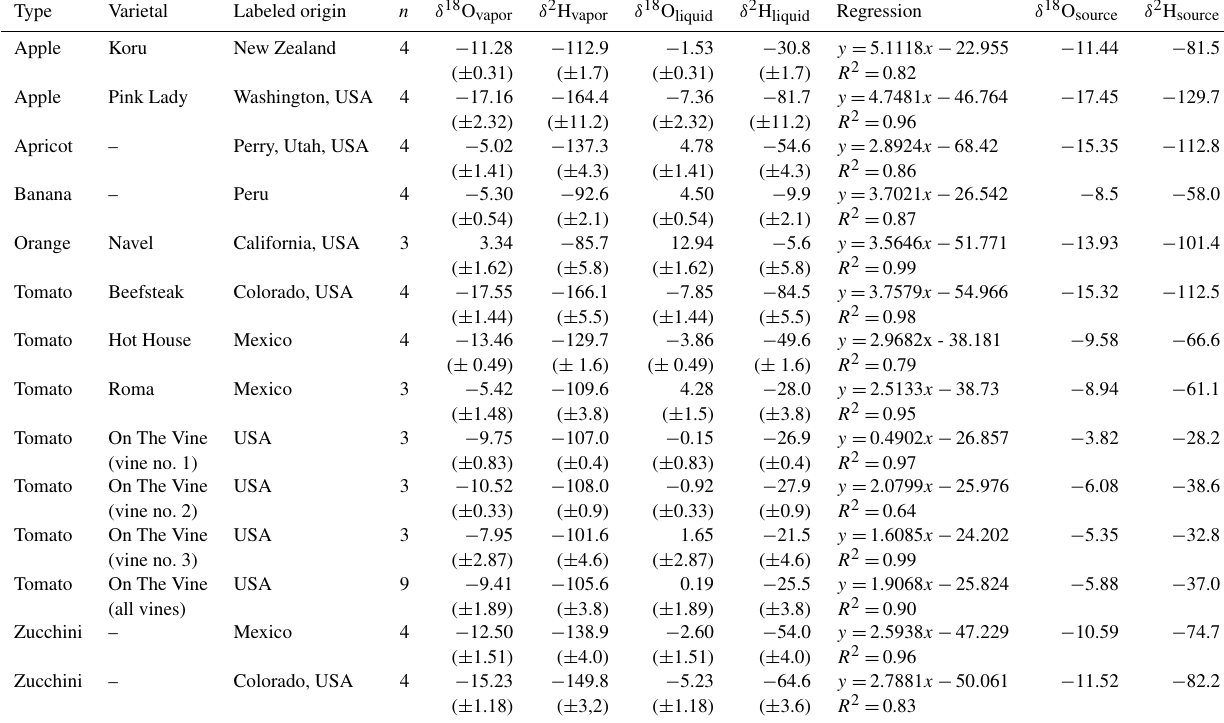
Table 1. Labeled origins, average measured δ 2 H vap and δ 18 O vap values, and calculated δ 2 H liq , δ 18 O liq , δ 2 H source , and δ 18 O source values ( ± 1 SD) and regression relationships of fruits and vegetables measured in this study and used in the accompanying teaching materials.